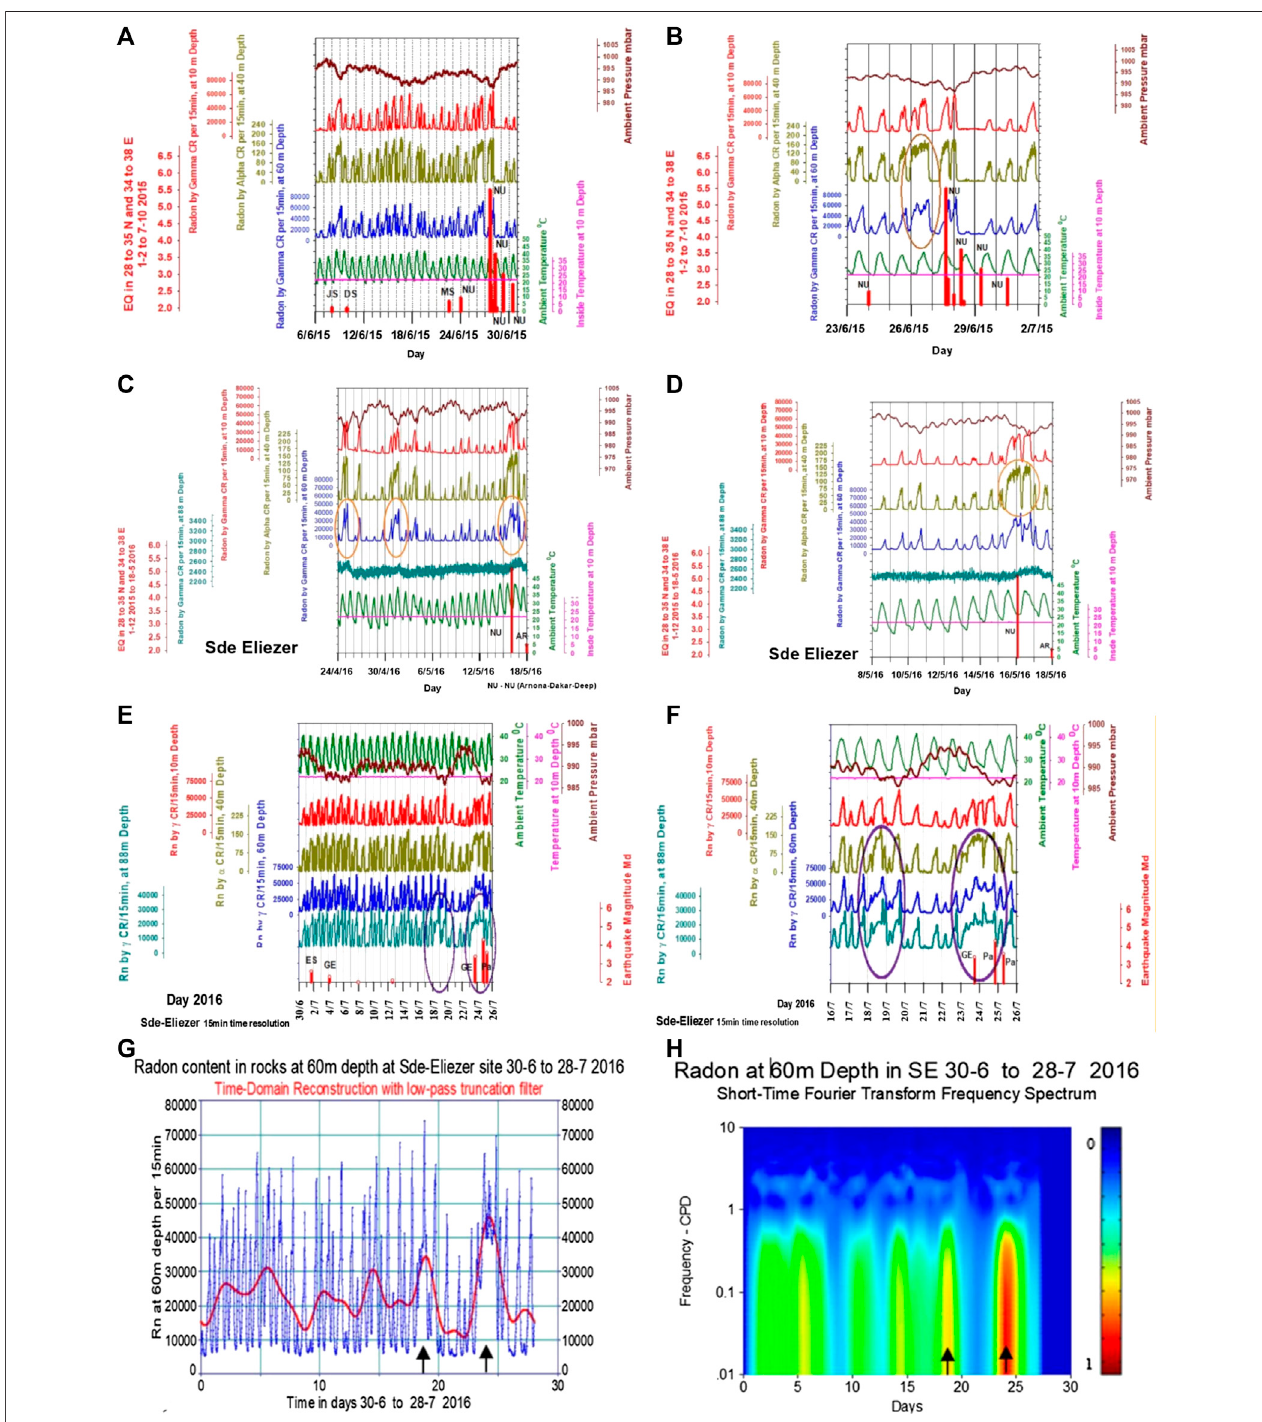
FIGURE12|Casea : (A) The fi rst-timeinterval, June2015,thatreveals anomalousbroadenedradonsignals while mostoftheradonsignalsarerecognizedas induced by climatic parameters by appearing once or twice aday at speci fi c times, 3 – 4 A.M. and 4 – 8 P.M. (B ) The 26 June radon anomalous signal isdifferent from the radon periodic signals appearing once or twice a day. Case b : (c) This time interval reveals anomalous broadened radon signals on 25 april, 1 and 15 May 2016, preceding by days and hours the Nuweiba, M 5.1 earthquake (NU) of May 16, 2016. (D) It happens while most of the radon signals are recognized as induced by climatic parameters, by appearing once or twice a day at speci fi c times. Case c : (E) and (F) These time intervals between 30 June to July 26, 2016 , reveals two anomalous broadened radon signals of at least 20 h each, precede the Palmyra Syria M (cid:1) 4.5 earthquake ( Pa ) on 25 July. It occurred 300 km northeast of the Hula Valley on one of the branches of the main fracture into Syria called Palmyrides, (Al-Zoubi et al., 2006). The signal from the deepest detector at 88 m depth became the